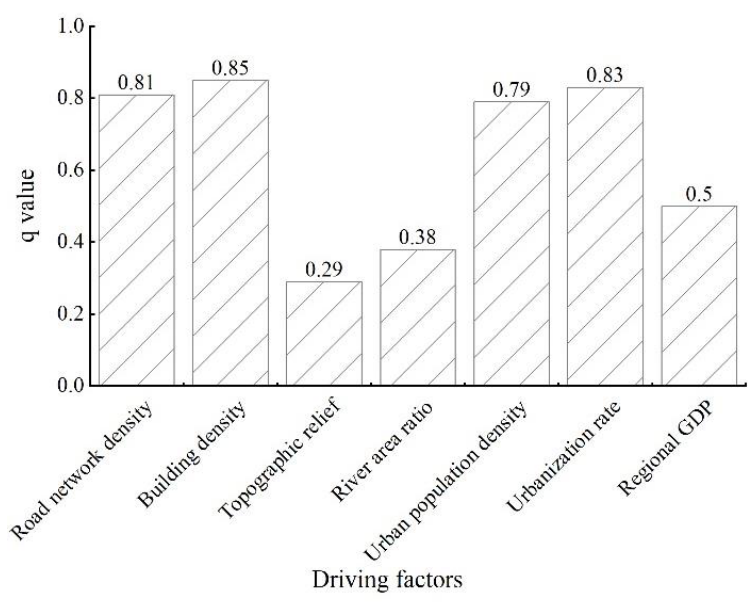
Figure 5. Factor detection results.